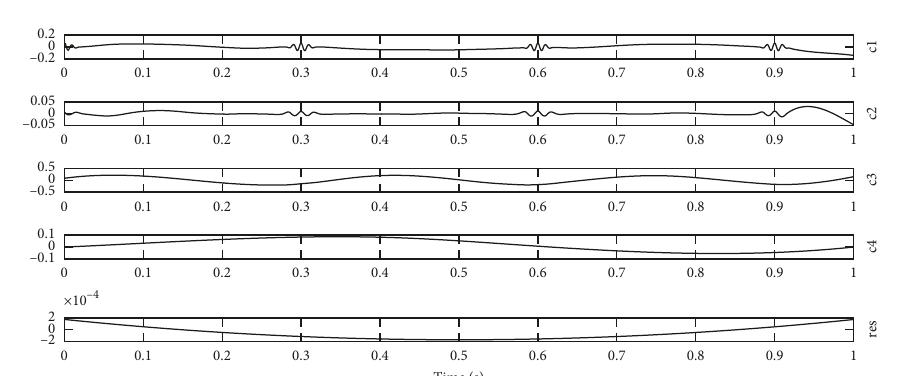
Figure 2: EMD decomposition results.